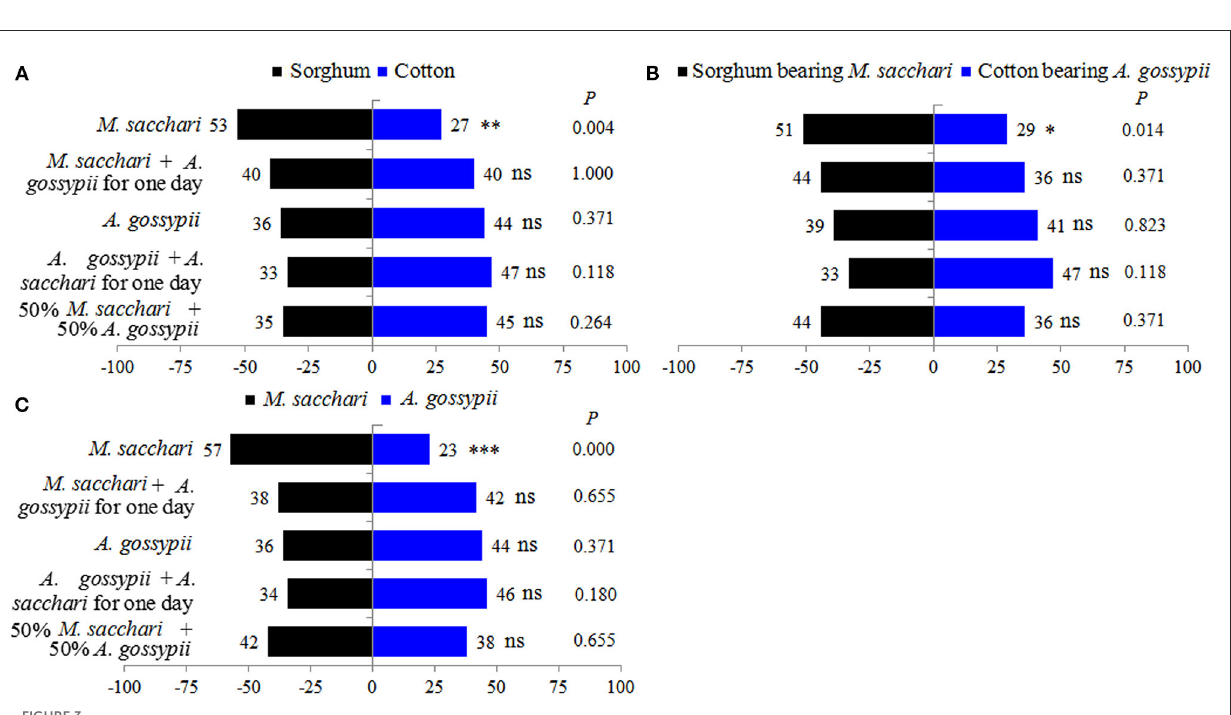
FIGURE3 Effect of aphid species on the behavioral responses of Propylaea japonica , originally fed different diets ( M. sacchari , A. gossypii , 50% M. sacchari + 50% A. gossypii , fed on M. sacchari then fed on A. gossypii for 1 day, or fed on A. gossypii then fed on M. sacchari for 1 day), to sorghum and cotton (A) , sorghum with M. sacchari and cotton with A. gossypii (B) , and M. sacchari and A. gossypii (C) . The X 2 test was used to analyze differences between the numbers of P. japonica in each arm of the Y-tube (* P < 0.05; ** P < 0.01; *** P < 0.001; ns,